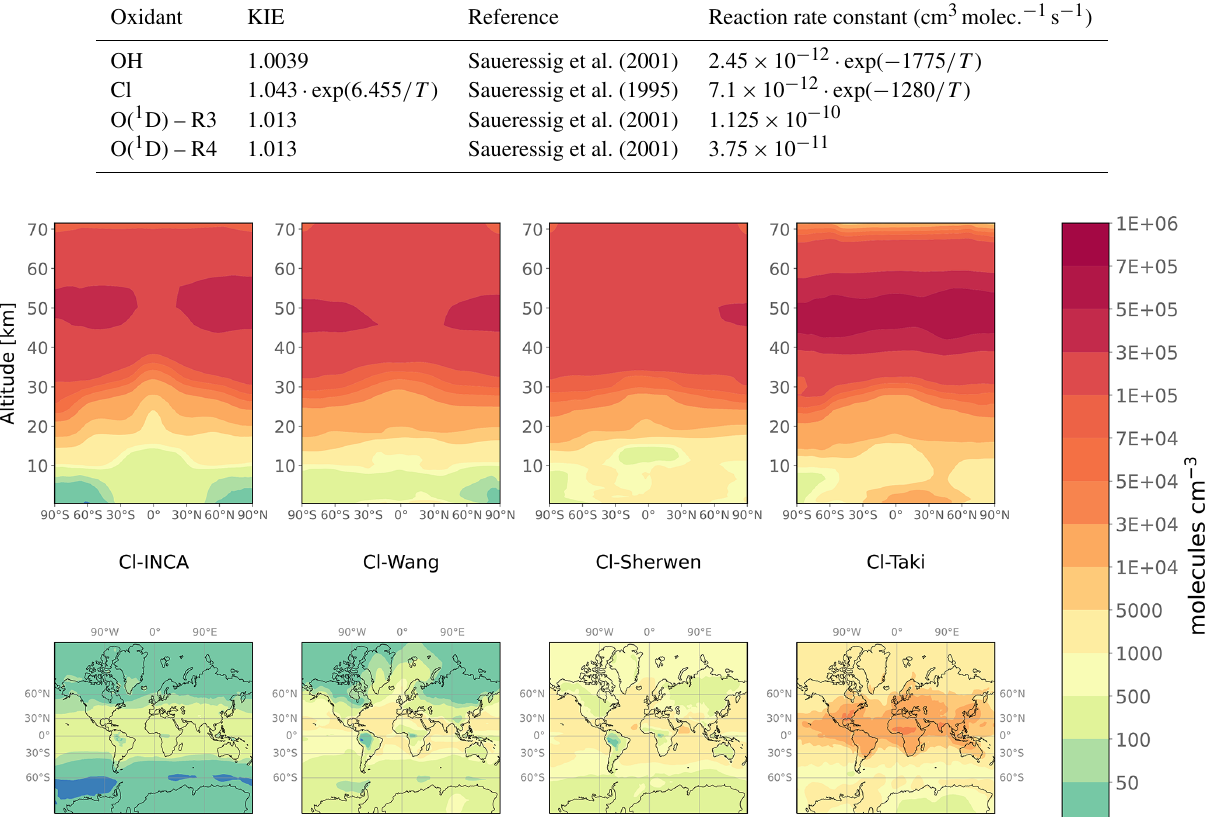
Table 1. Reaction rate constants and KIEs of CH 4 chemical sinks. The reaction rate constants are taken from Burkholder et al. (2015). Oxidant